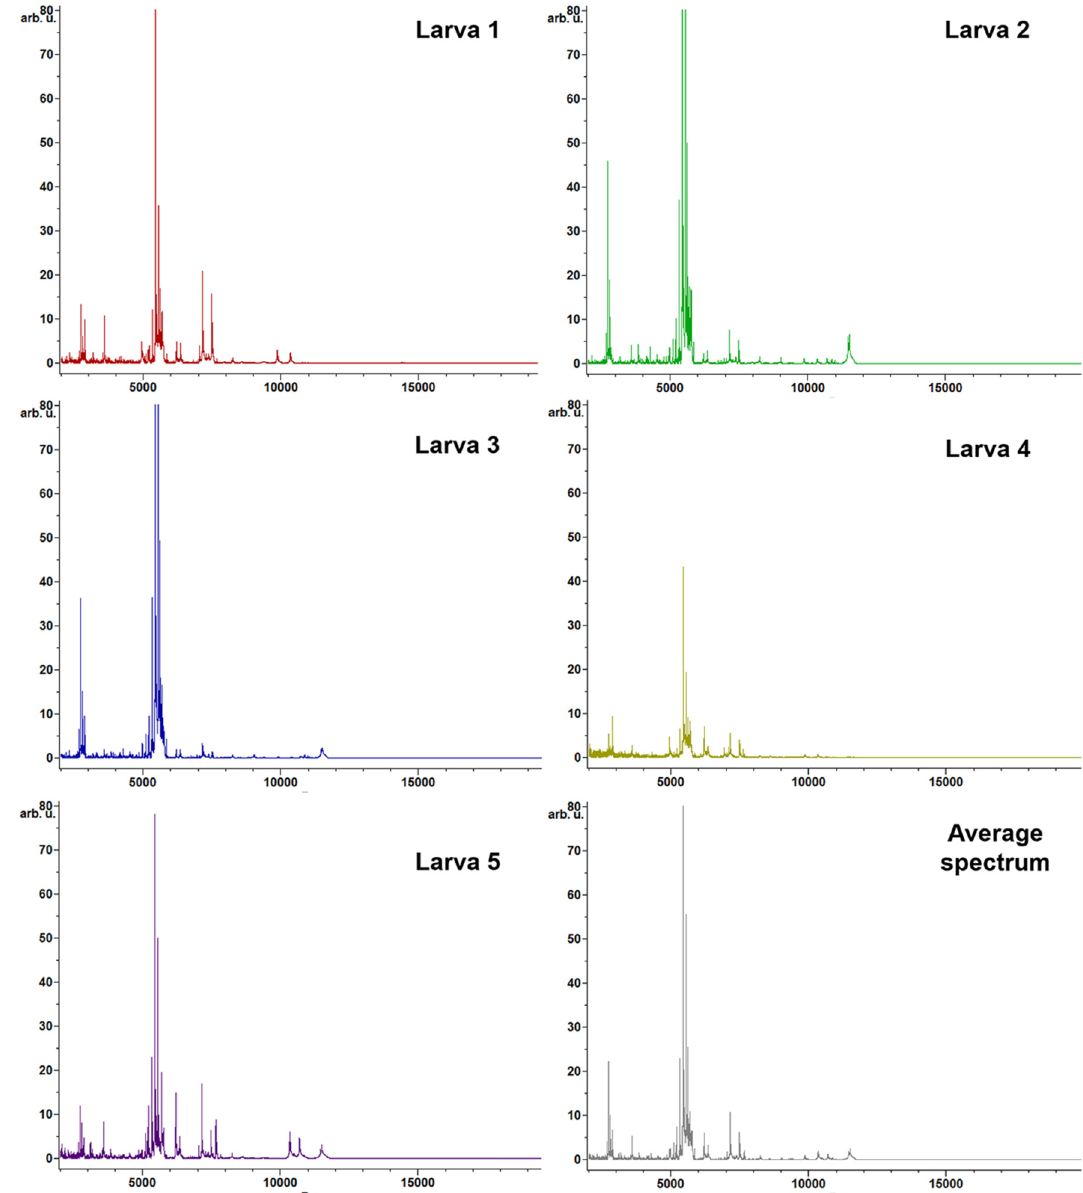
Figure 2. Representative protein profiling of Anisakis spp. by Biotyper MALDI–TOF MS. The average spectrum for each sample is depicted, as well as the average spectrum obtained from the entire spectra dataset. The m/z values are expressed in Da, and the signal intensities are reported in a scale of arbitrary units (arb. u.).